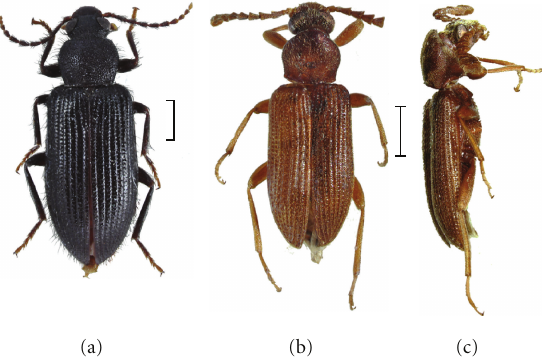
Figure 1: Habitus. (a) Litopous baehri sp. nov. female; (b) Scaphin- ion clavatus sp. nov. male, dorsal; (c) ditto, lateral. Scale lines 1